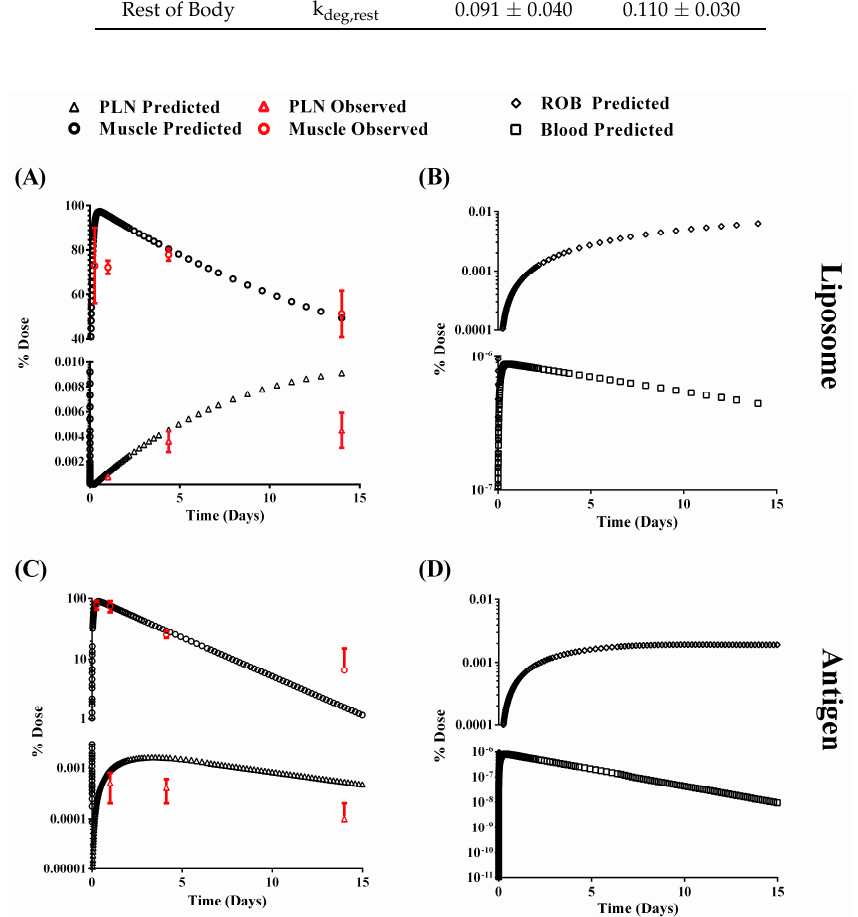
Figure 5. PBPK model predictions for liposome ( A , B ) and antigen ( C , D ). Muscle and PLN data is shown in ( A , C ), and blood and ROB in ( B , D ). Red data points represent observed data.